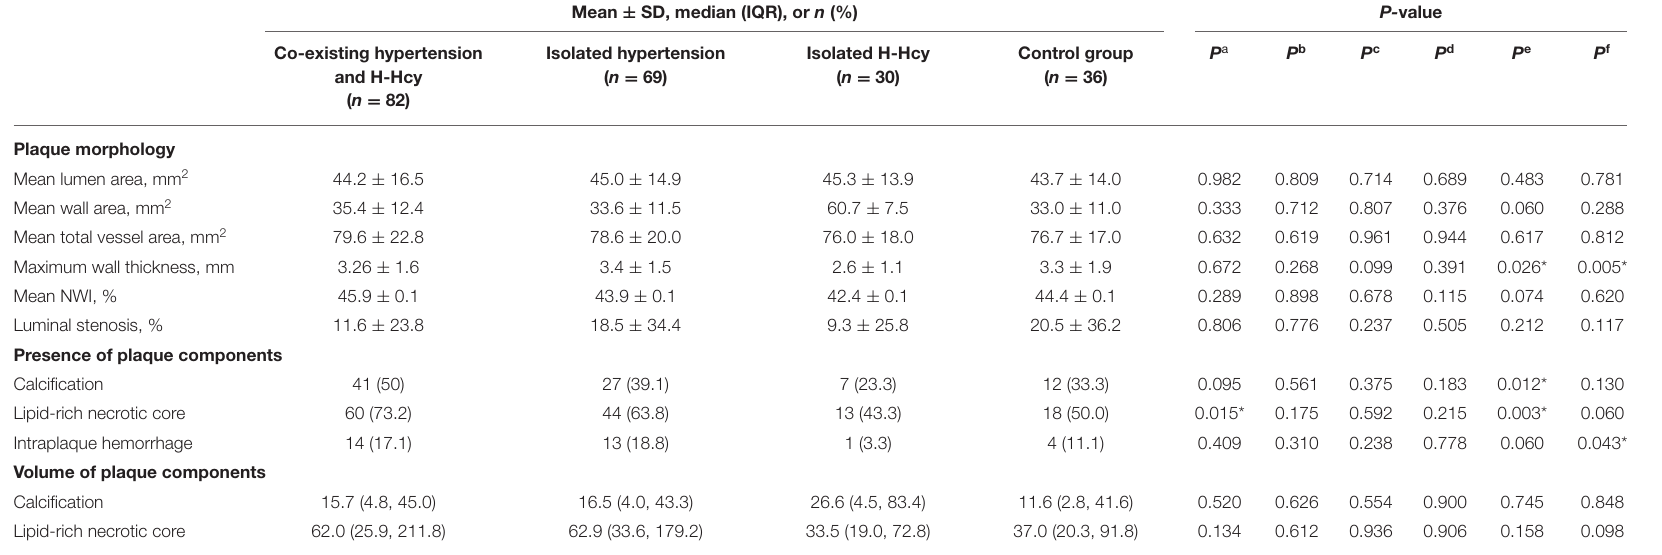
TABLE 2 | Comparison of carotid plaque features among different groups ( n = 217).